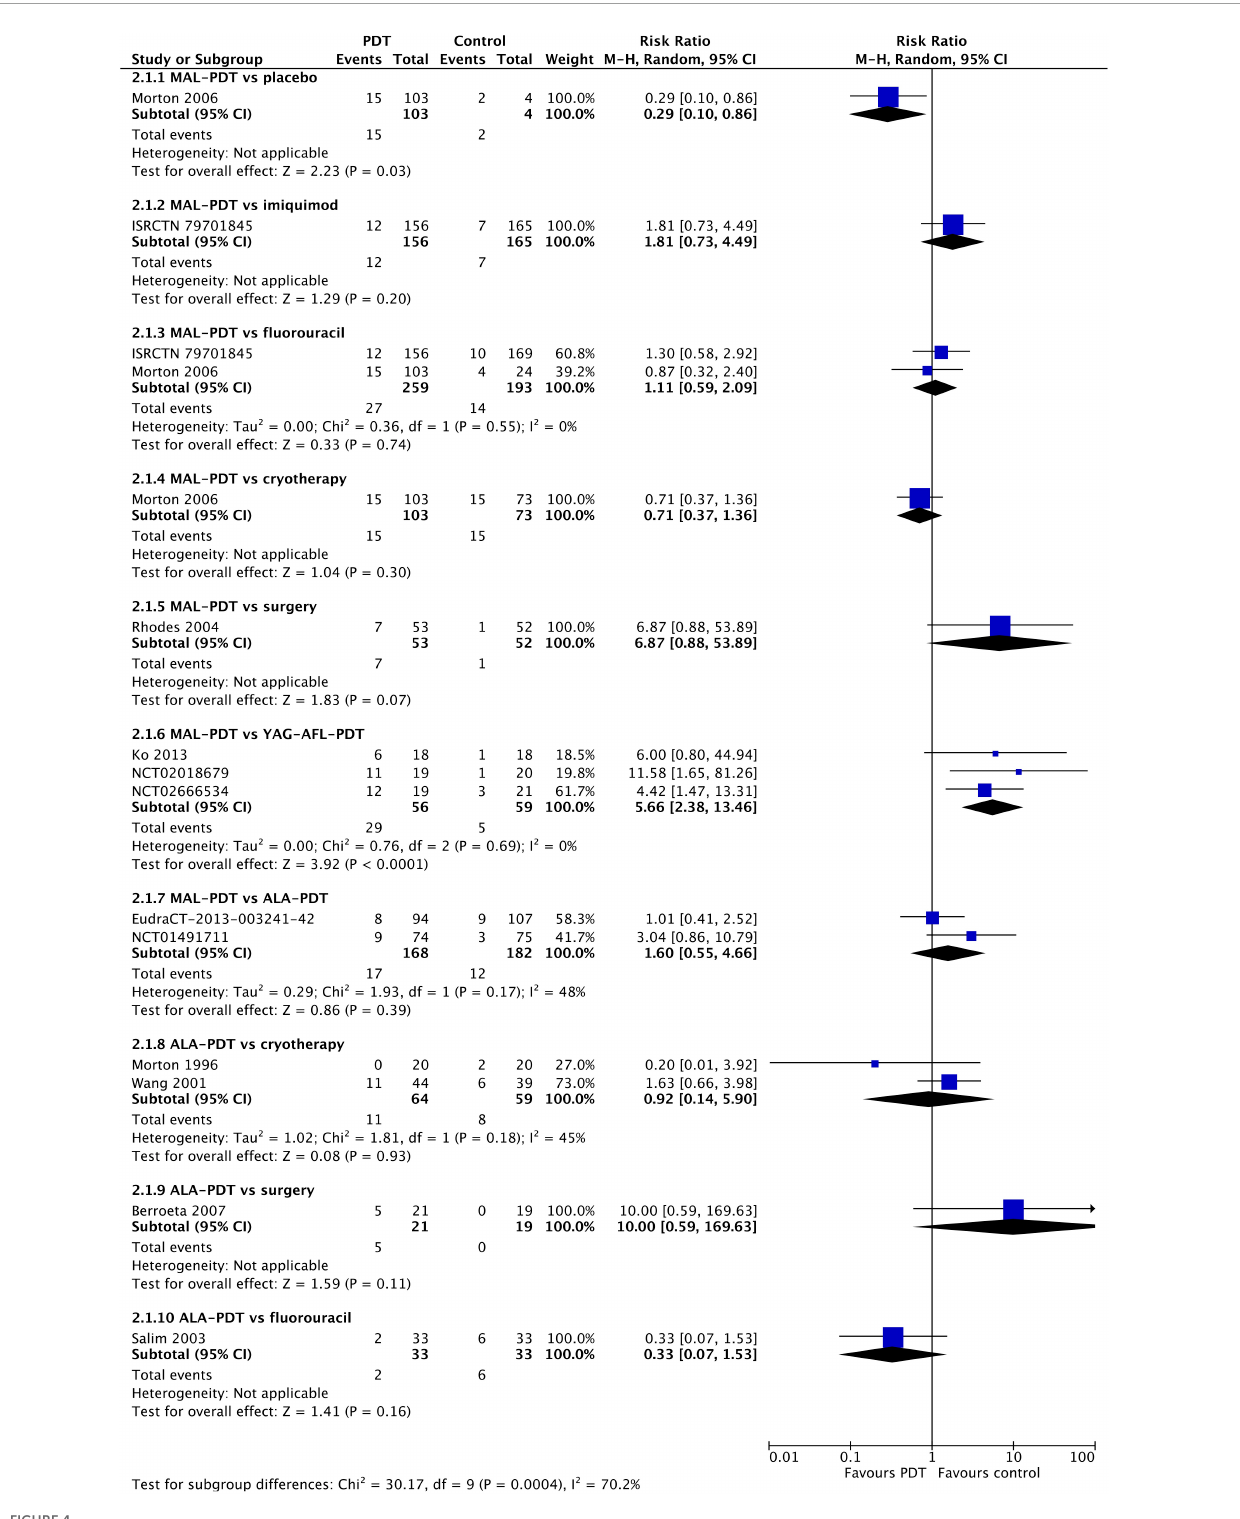
surgery and YAG-AFL-PDT at 24 m (one study), and imiquimod at 36 m (one